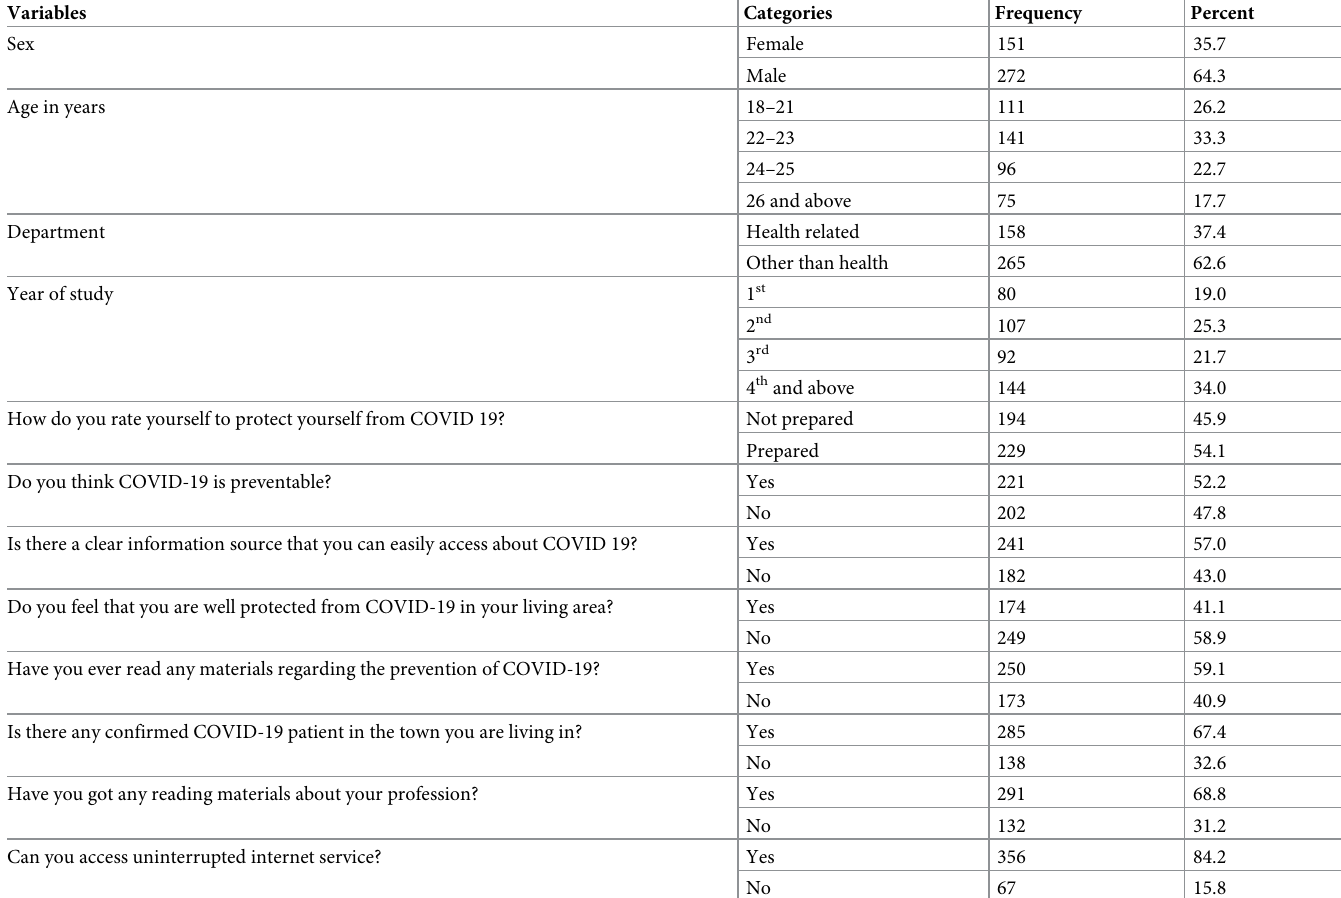
Table 1. Socio-demographic characteristics of the study participants of depression, anxiety, stress among Ethiopian University students during an early stage of COVID-19, 2020 (N =